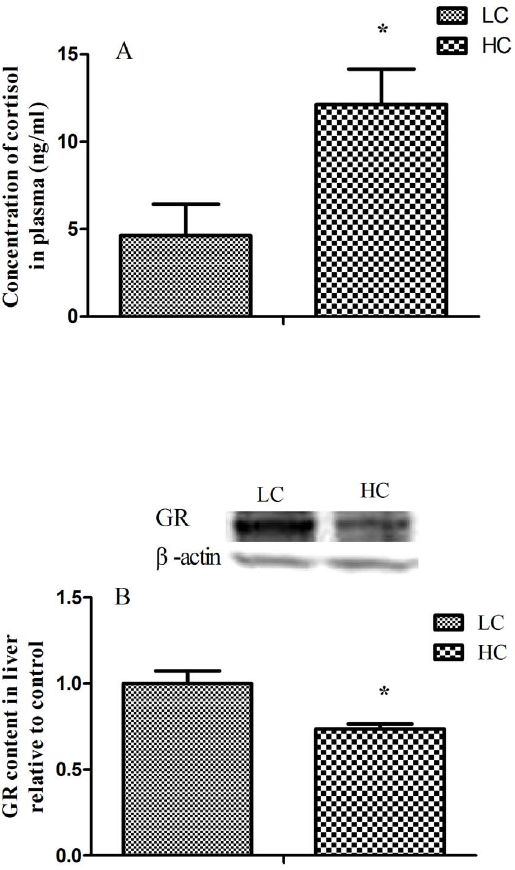
Figure 2. Plasma cortisol concentration (A) and hepatic glucocorticoid receptor (GR) protein expression (B). The concentrations of cortisol were significantly up-regulation and the GR protein expression was significantly down-regulation. Values are mean 6 standard error of the mean (SEM); *p , 0.05 vs. LC.